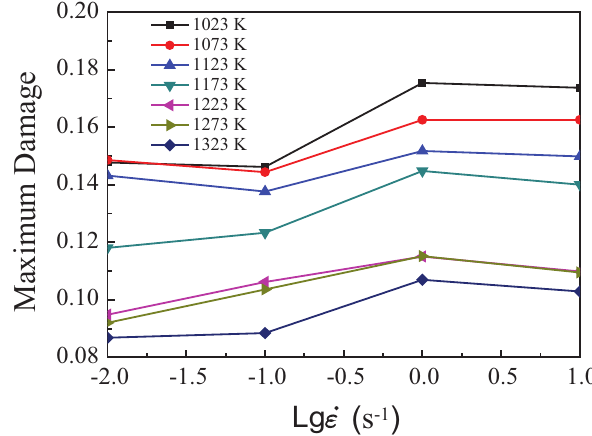
Figure 6: The relationships between maximum damage and strain rate at the end of compressing process under different